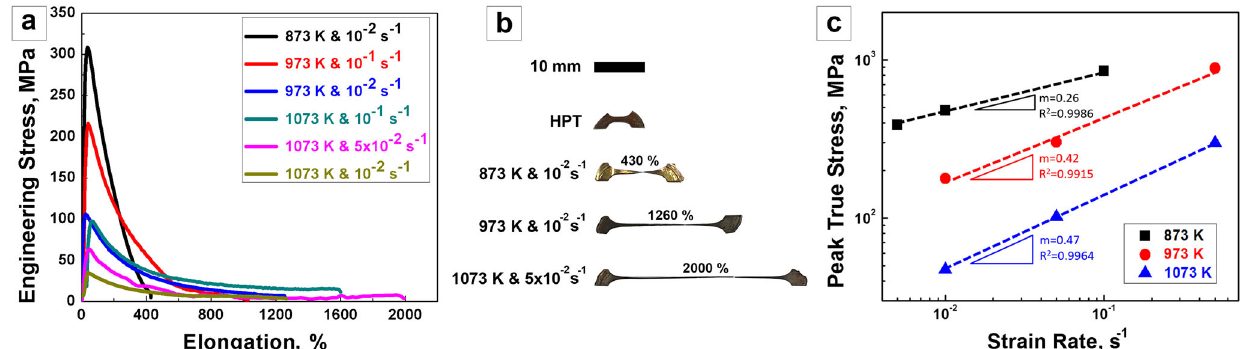
Fig. 2 Superplastic behavior of Al 9 (CoCrFeMnNi) 91 high-entropy alloy (HEA). a Engineering stress-strain curves of tensile tests at 873, 973, and 1073 K paired with various strain rates from 10 − 1 to 10 − 2 s − 1 , b Images of representative fractured specimens with their testing parameters, c Estimated strain-rate sensitivity ( m ) from true stress against strain rate in double logarithmic